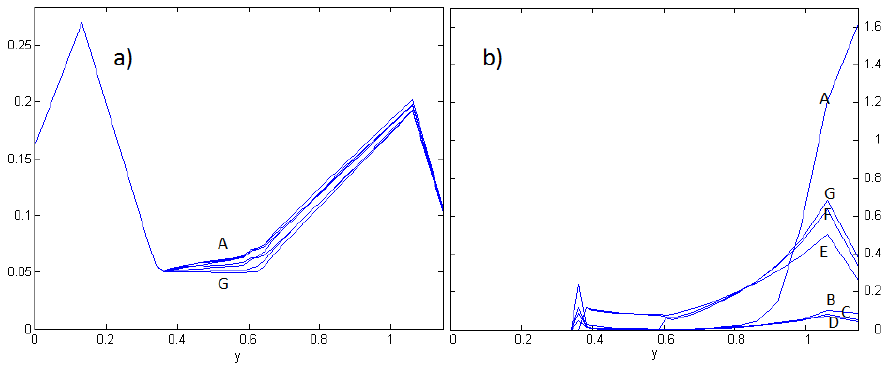
Figure 4. Wall friction coefficient: ( a ) f f ; ( b ) f g .